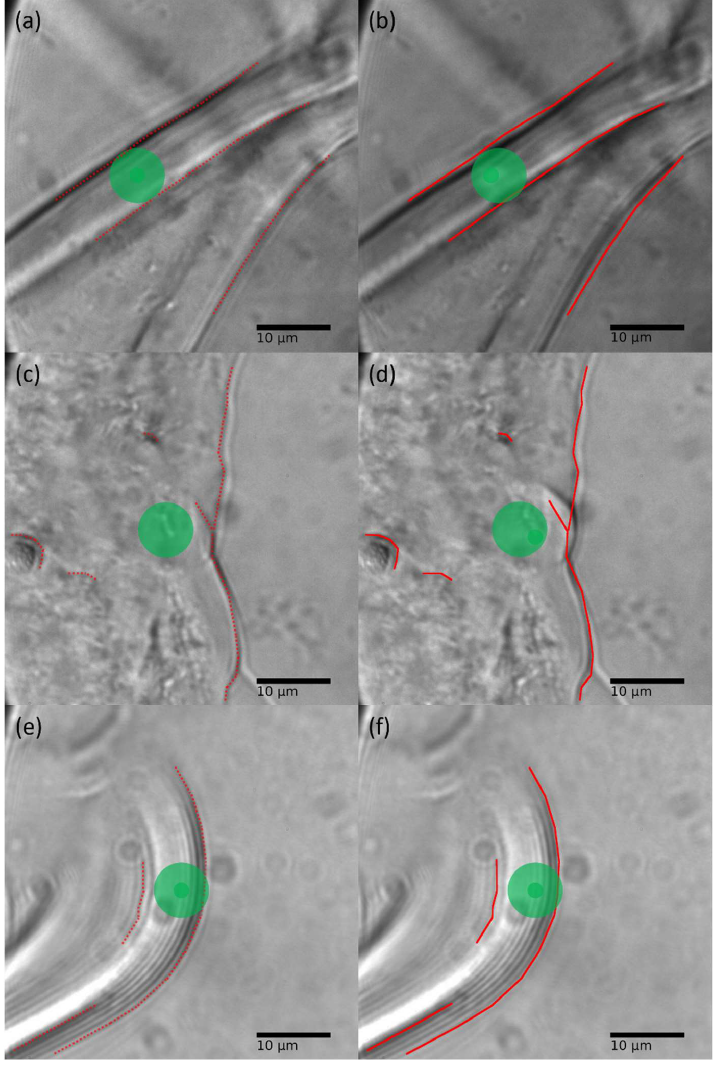
Figure 3. Light microscopy images of pristine (left panels) and photoactuated regions (right panels) of hydrogel layers prepared from ( a , b ) poly(NipAAm 86.5% -HEAm 10% -co-o-MREAm 2.5% -co- BPAAm 1% ) P 22°C , ( c , d ) poly(NipAAm 56.25% -HEAm 40.25% -co-o-MREAm 2.5% -co-BPAAm 1% ) P 35°C , and ( e , f ) poly(NipAAm 27.5% -HEAm 67.5% -co-o-MREAm 2.5% -co-BPAAm 2.5% ) P 45°C . Photoactuation was per- formed with a laser at λ = 532 nm and 3750 µW (irradiation region marked by a green spot). Red lines indicate notable gel features that were photoactuated.